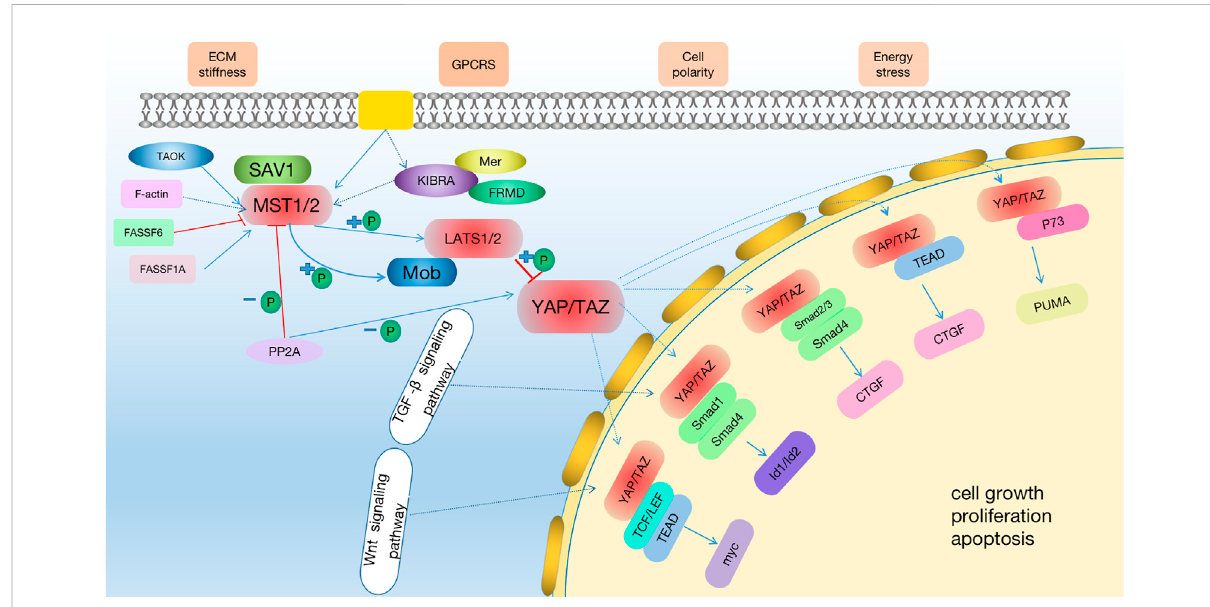
The Hippo signaling pathway. The hippo pathway can be activated by TAO kinase, which phosphorylates MST1/2 in its activation ring. MST1/ 2phosphorylatedLATS1/2sequentiallywiththehelpofSAV1andMOB1/2andthenactivateYAP/TAZ.Potentialtreatments:Throughtheactivationof the hippo signaling pathway, MST1/2 and LATS1/2 phosphorylation are activated to improve the level of p-YAP or inhibit the expression of YAP, and then regulate the downstream effector factors to achieve the therapeutic effect on kidney diseases. At the same time, in the early stage of AKI, the expression of YAP is increased, which promotes cell proliferation and promotes the recovery of kidney